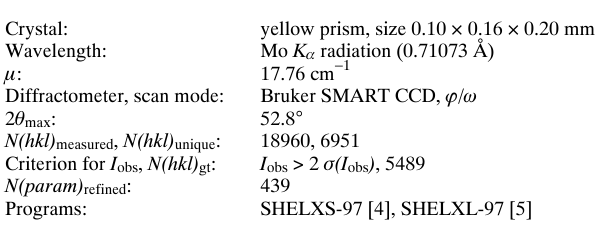
Table 1. D a t a collection a nd h a ndling. Table 2. C ontinued